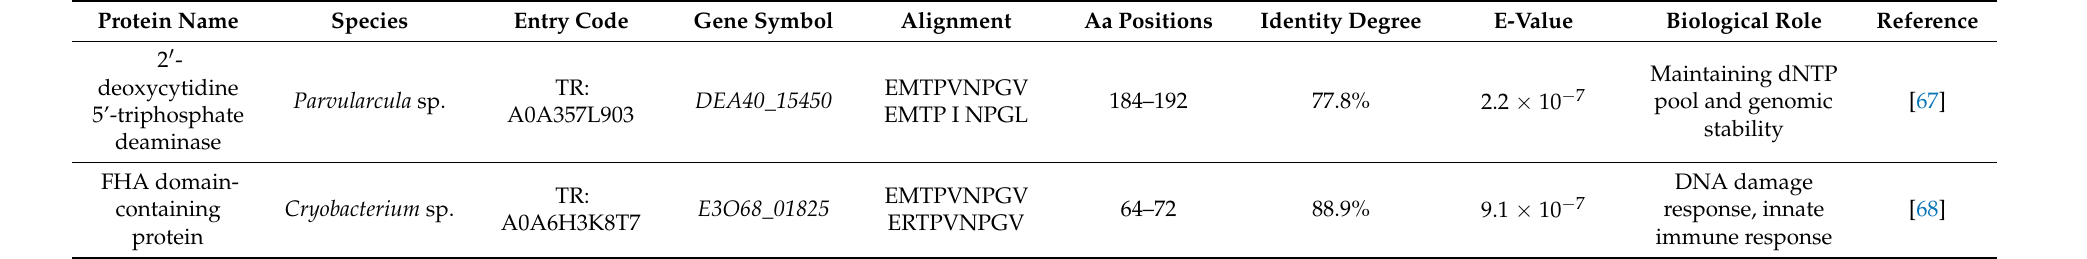
Table 2. Representative proteins retrieved from the UniProtKB database as containing GIP-9-like motifs (at E-value <